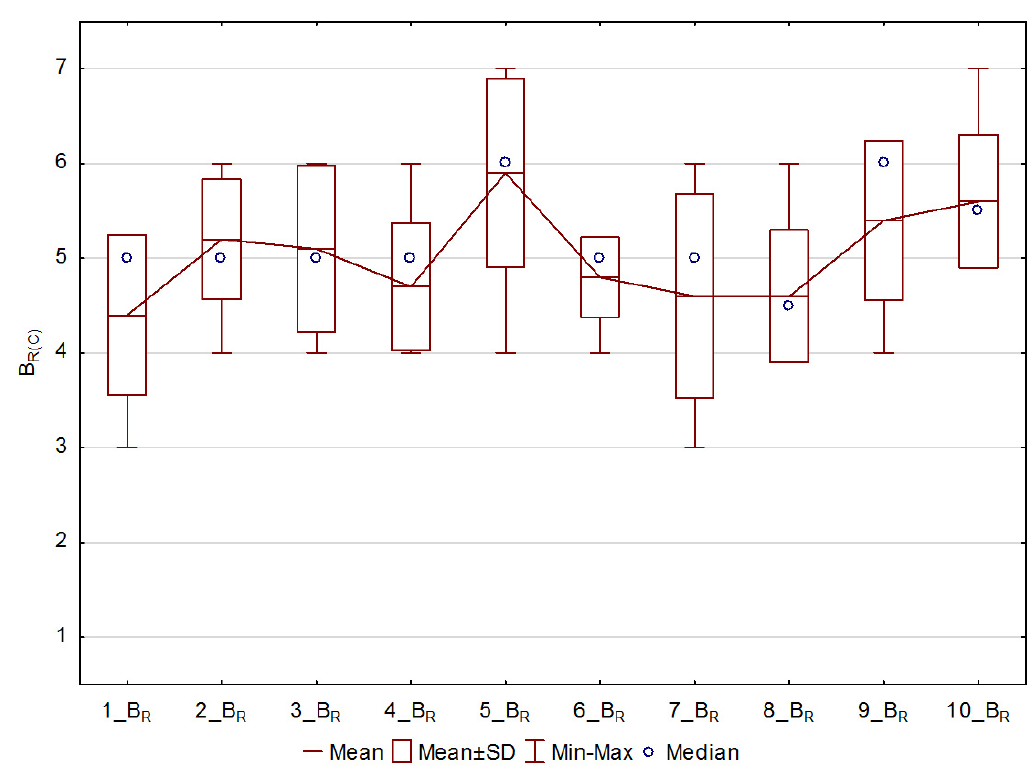
Figure 28. Corridor brightness perception for group C.